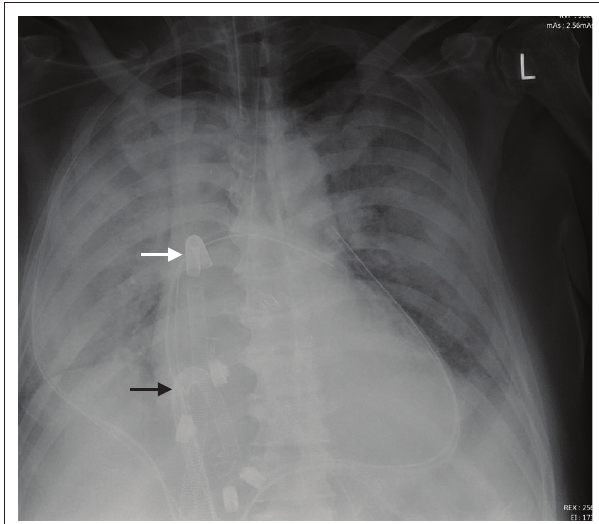
FIGURE 3: Chest radiograph showing a veno-venous extracorporeal membrane oxygenation with the cannulae in the superior vena cava (white arrow) and right atrium (black arrow) in a 66-year-old male with congestive heart failure (CHF) and pulmonary oedema.